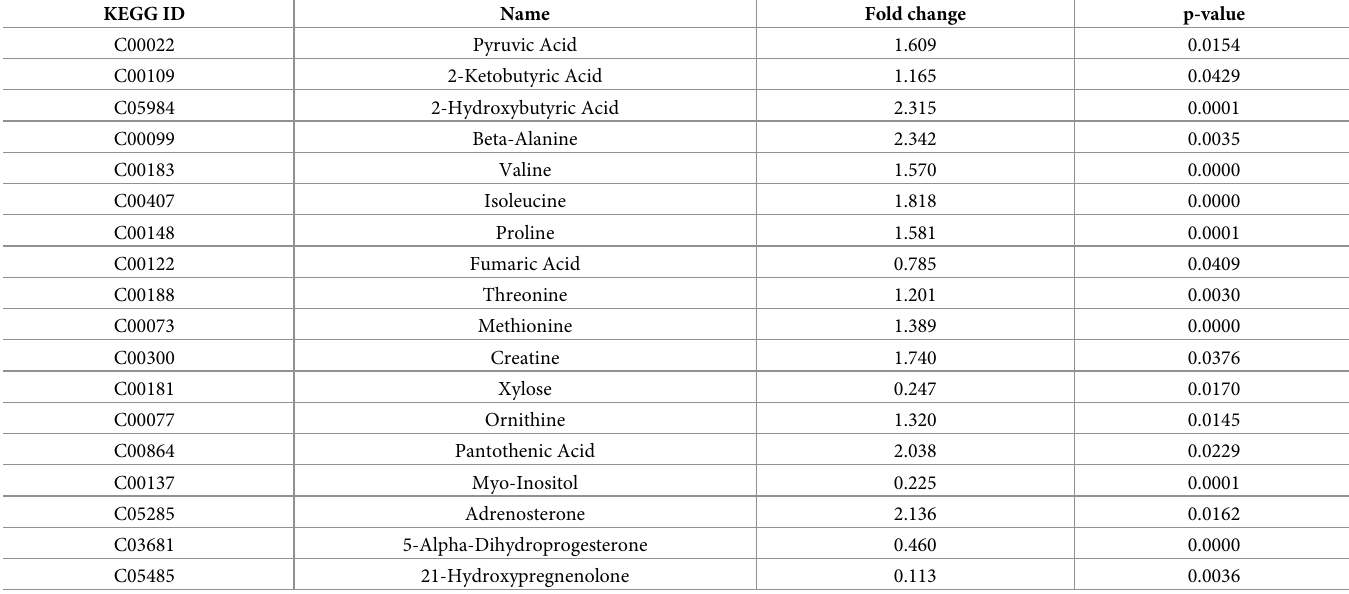
Table 2. Differential metabolites involved in significantly perturbed metabolic